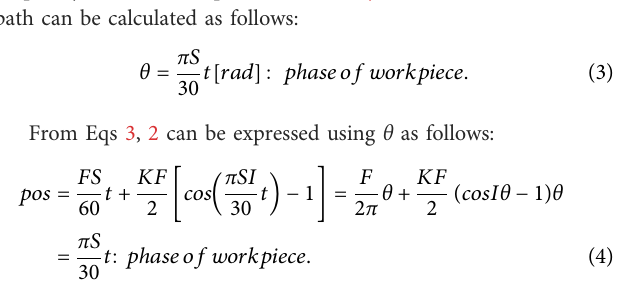
Figure 3 is a color map with respect to the height of the machined surface when the parameters I and K were .5 and 1.5, respectively. The axes indicated the feed position, phase, and surface height of the workpiece, respectively. This allowed visual con fi rmation of the cutting area, air cutting, and machined surface when the I and K values were varied. The simulation method was based on a Z-map. The division width of the workpiece surface was set to 5 μ m and .9 ° in the axial and peripheral directions, respectively. The division width of the ridge representing the cutting-edge shape of the tool was calculated as 1 μ m. From Figure 3, it is con fi rmed how the surface is fi nished with the vibration. As the phase of cutting-edge changes, the contact point